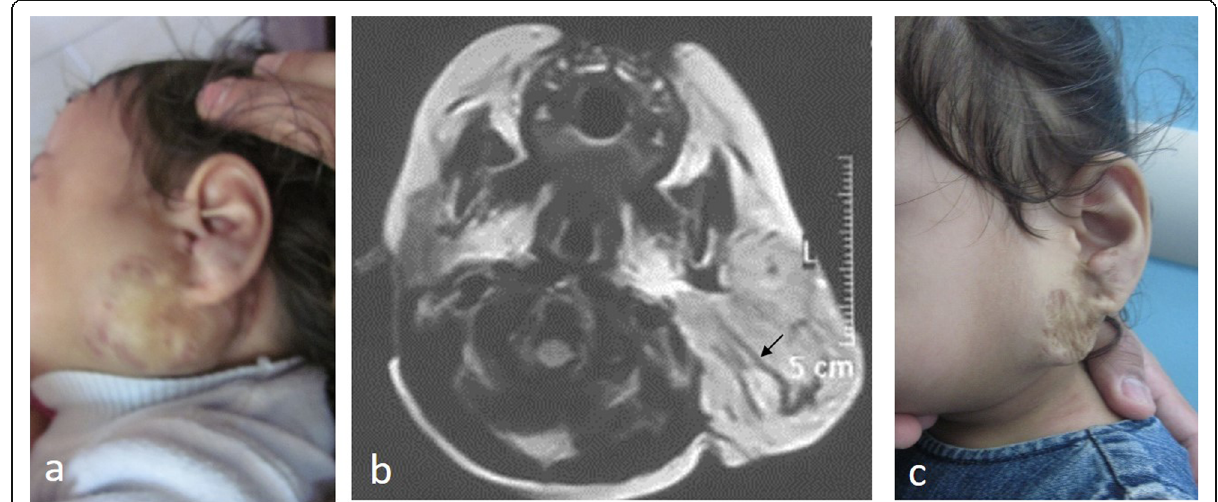
Fig. 4 Infantile haemangioma of the parotid. a The tumour size at presentation (14-month-old girl). b Axial MRI (T2WI) showing typical hyperintense mass lesion with characteristic flow voids (black arrow). c The same patient at 31 months of age showing good response to systemic propranolol and intralesional corticosteroid injection